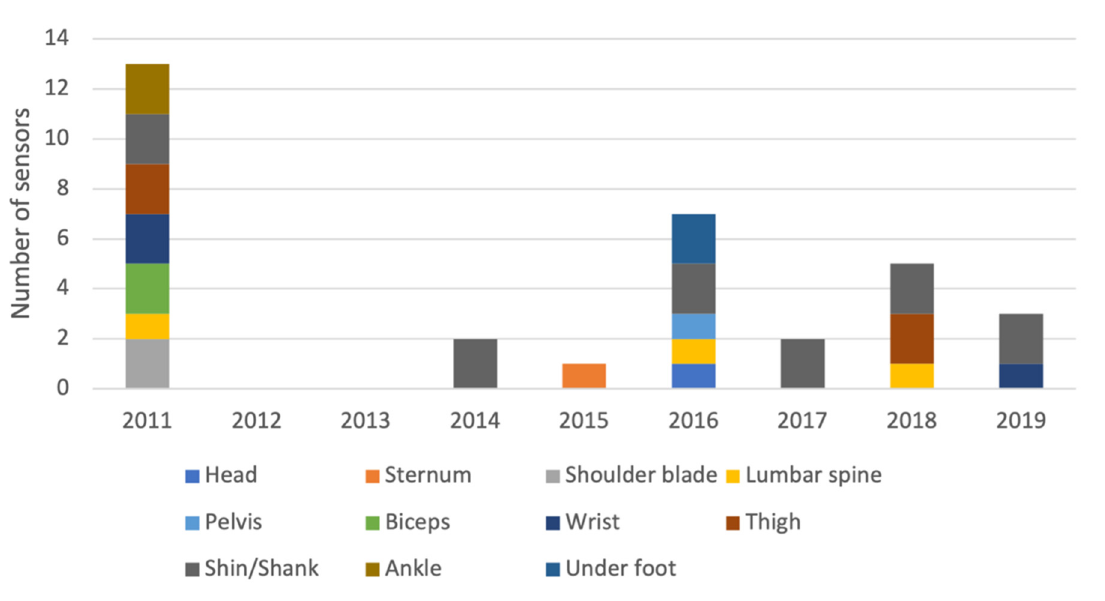
Figure A2. Number of sensors per body location for articles in Table 4, per publication year.